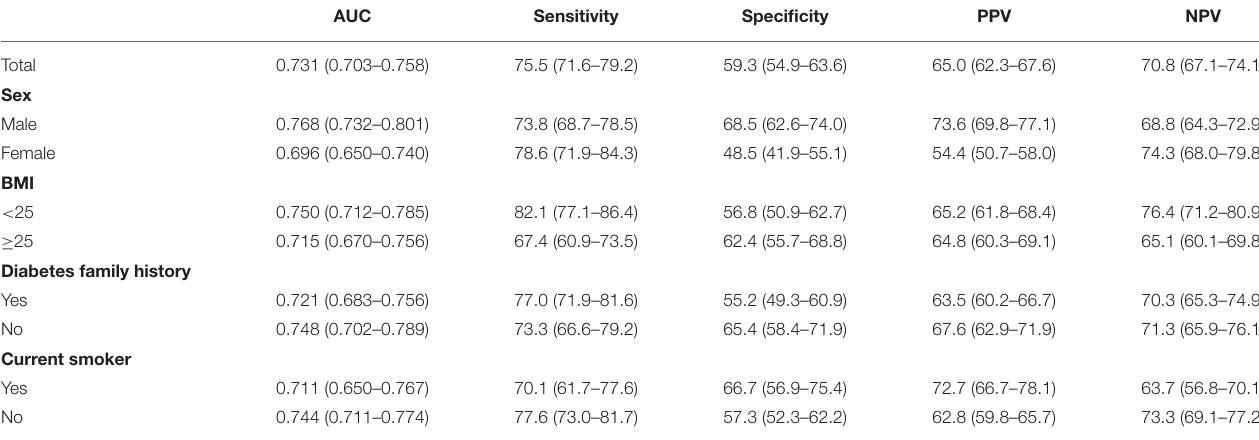
TABLE 3 | The efficacy of AGE age ≥ 43.2 in early identifying LEAD in type 2 diabetic